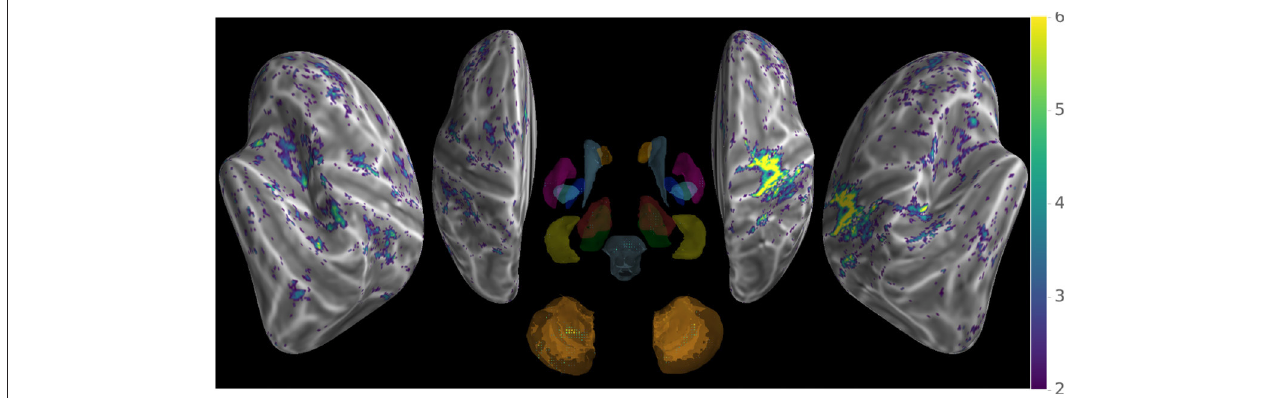
FIGURE 6 | Wholebrain exploded view displaying a T -value map of an activation for a single block of about 5 s. during left-hand finger motor sequence production, showing activity in contralateral primary sensorimotor cortex and the anterior lobe of ipsilateral